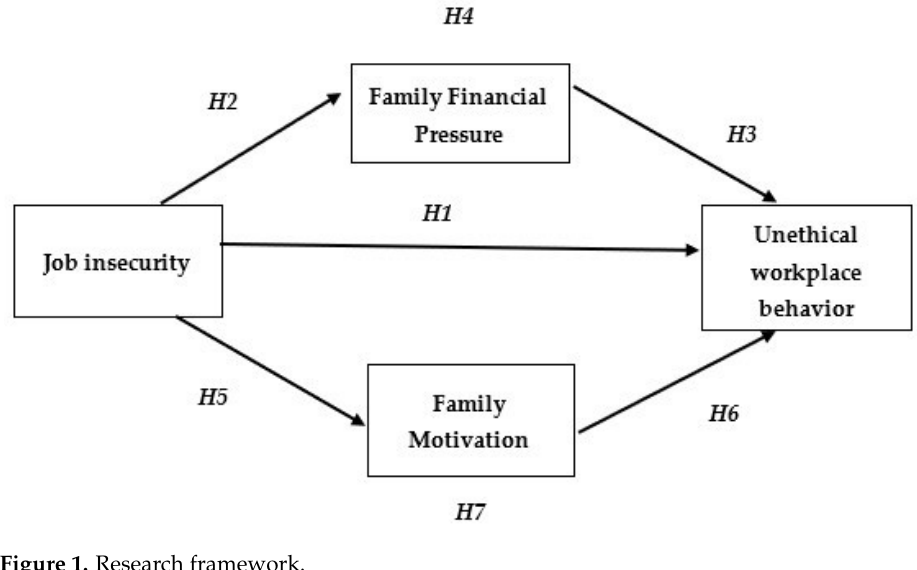
Figure 1. Research framework